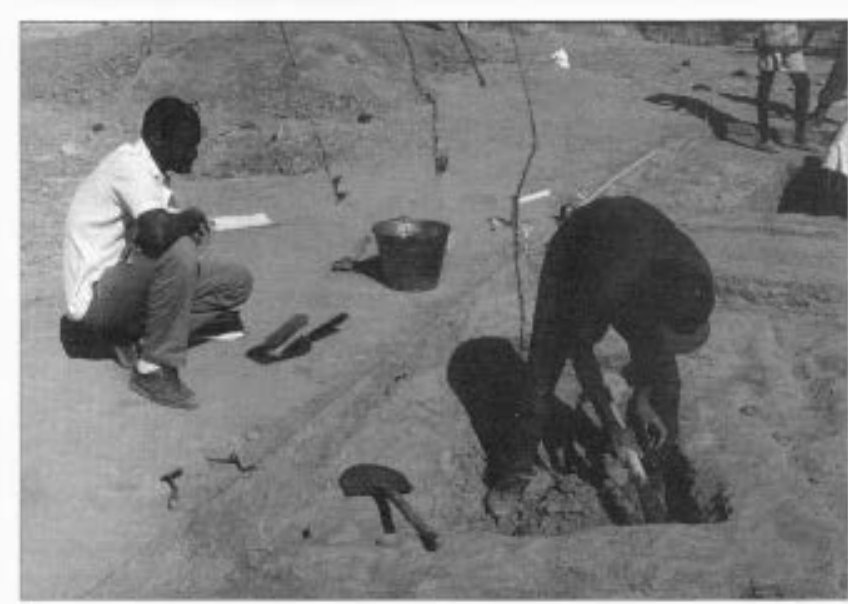
Figure 2 Tereba Togola supervising excavation at Tango Maare Diabal in 1 995.